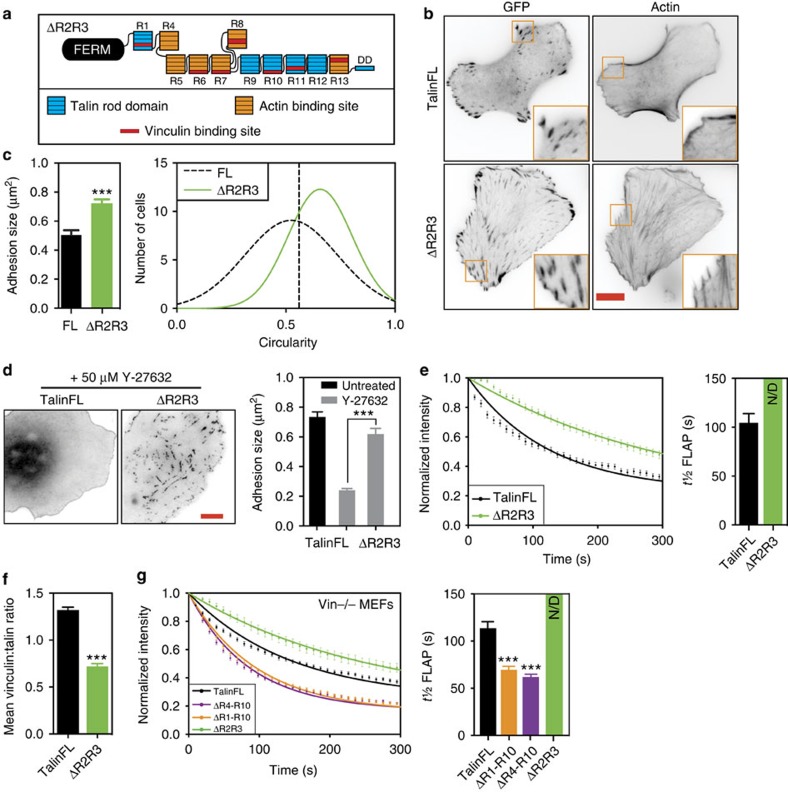
Deletion of Talin R2R3 stabilises FAs.(a) Cartoon of the talΔR2R3 construct. (b,c) TKO cells expressing talΔR2R3 have more prominent actin stress fibres associated with larger FAs than those in cells expressing talinFL; cells expressing talΔR2R3 are more circular than talinFL cells (n=70–90 cells, from three independent experiments, error bars are±s.e.m., ***=P<0.001 (ANOVA)), scale bar in b, 10 μm. (d) Left panel, representative images of TKO cells expressing indicated constructs treated with DMEM containing 50 μM Y-27632 or an equivalent volume of water for 30 min. Note that Y-27632 resulted in a reduction of adhesion size of cells expressing talinFL compared with either untreated control cells or cells expressing talΔR2R3. (e) FLAP measurement curves of talΔR2R3 and talinFL in TKO cells. Curves (left panel) and quantification of t½ (right panel) show the reduced mobility of talΔR2R3 in comparison to talinFL (n=49–51 FAs, from three independent experiments). The almost linear decay of talΔR2R3 prevented appropriate fitting, hence accurate t½ FLAP could not be determined; N/D, not determined. (f) Quantification of vinculin recruitment in TKO cells expressing talΔR2R3. Note the reduced levels of vinculin in FAs of talΔR2R3 cells compared with levels in FAs of control cells expressing talinFL (n>70, from three independent experiments, error bars are±s.e.m., ***=P<0.001 (ANOVA)). (g) FLAP curves of experiments in MEFvin−/− cells (left panel) transfected with talinFL or talΔR2R3. Quantification of FLAP (right panel) showing t½ times for each construct. Note that even in absence of vinculin, talΔR2R3 has a slower turnover than talinFL. The almost linear decay of talΔR2R3 prevented appropriate fitting, hence accurate t½ FLAP could not be determined; N/D=not determined. (n=35–60 FAs, from three independent experiments, error bars are±s.e.m.).